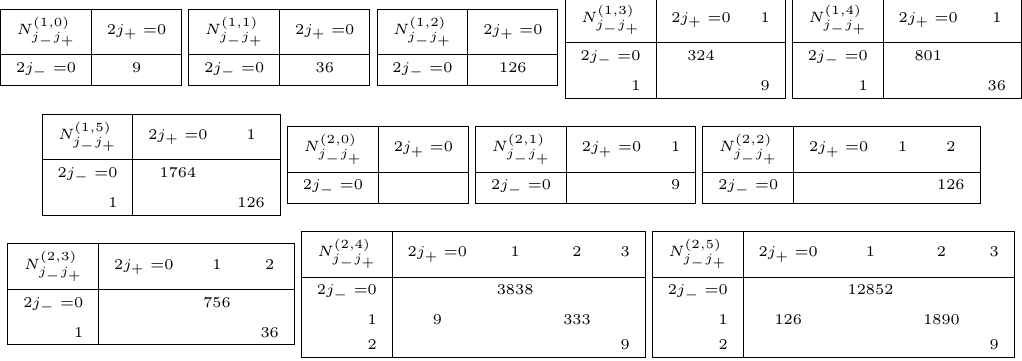
Table 10 . Re(cid:12)ned BPS invariants N ( b;d )